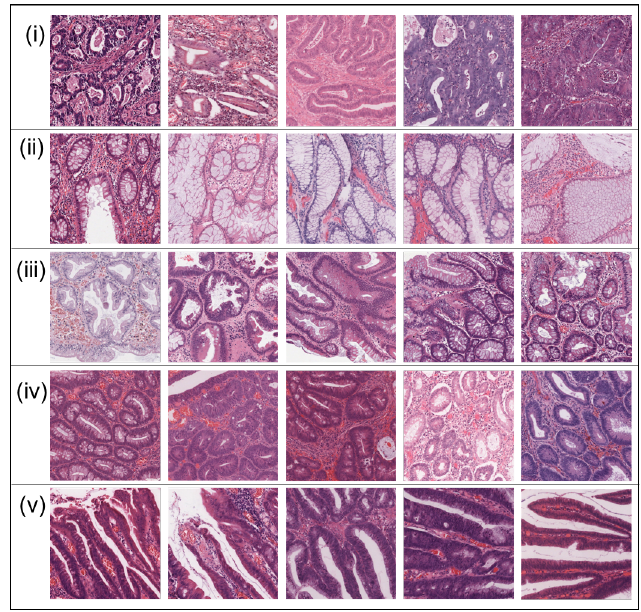
Figure 1. H&E samples of colorectal polyps. The figure shows five different histological categories of polyps, one per line: ( i ) Adenocarcinoma (AC); ( ii ) Hyperplastic polyp (H); ( iii ) Serrated adenoma (S); ( iv ) Tubular adenoma (T); ( v ) Villous adenoma